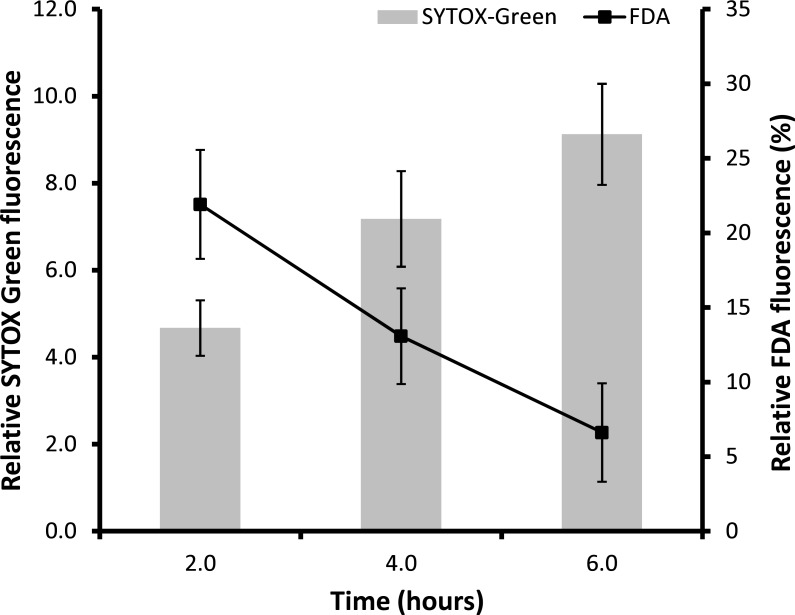
Permeabilization and cell viability of hyphae treated with 50 μg/ml pterostilbene.Uptake over time of 0.5 μM SYTOX green and 1μg/ml fluorescein diacetate (FDA) by hyphae cultures. Left axis: relative SYTOX green fluorescence (fold-change). Right axis: relative FDA fluorescence (%). Vertical bars represent standard deviation. All values were statistically significant at p<0.01 in Student’s t-test with degrees of freedom = 8.